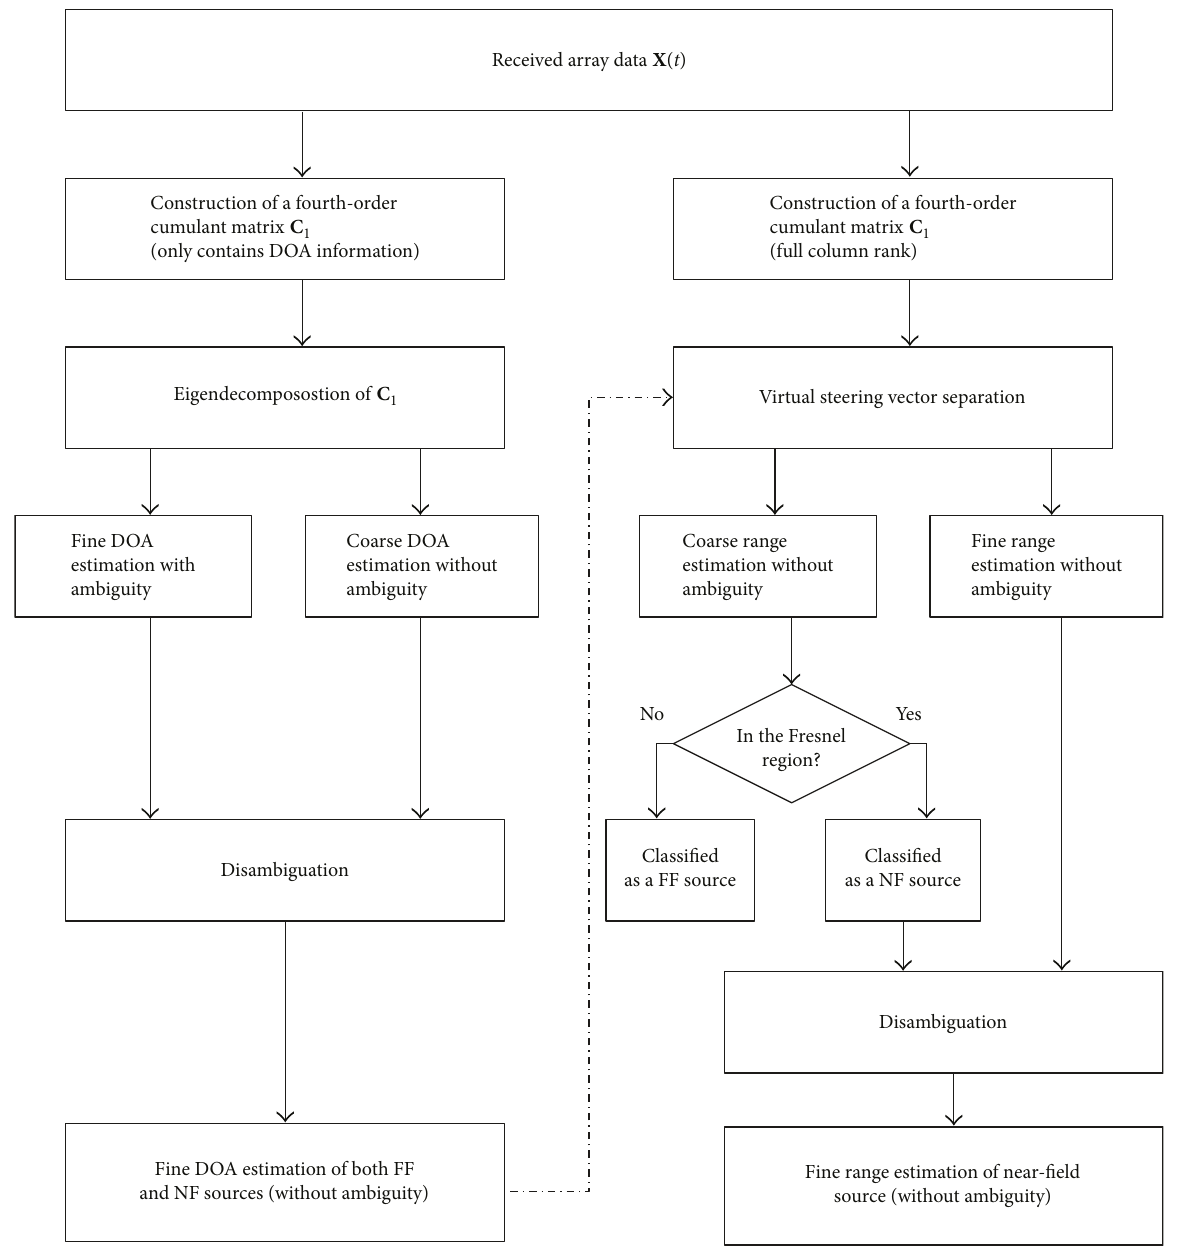
Figure 2: Flow graph of the CDSSI